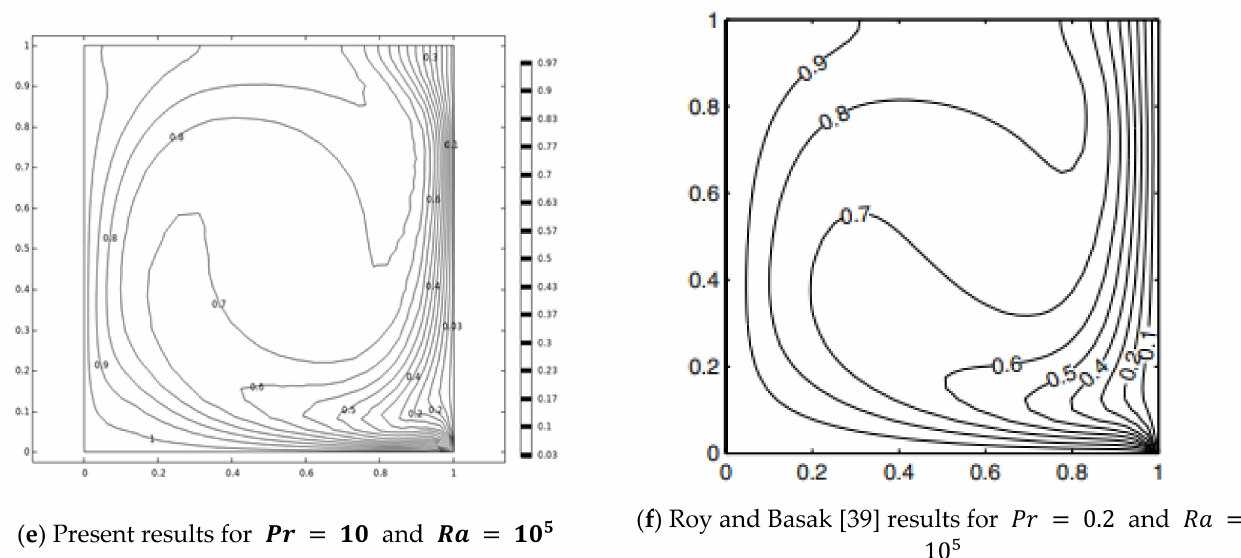
Figure 3. Comparison of stream lines and isothermal contours with Roy and Basak [39].